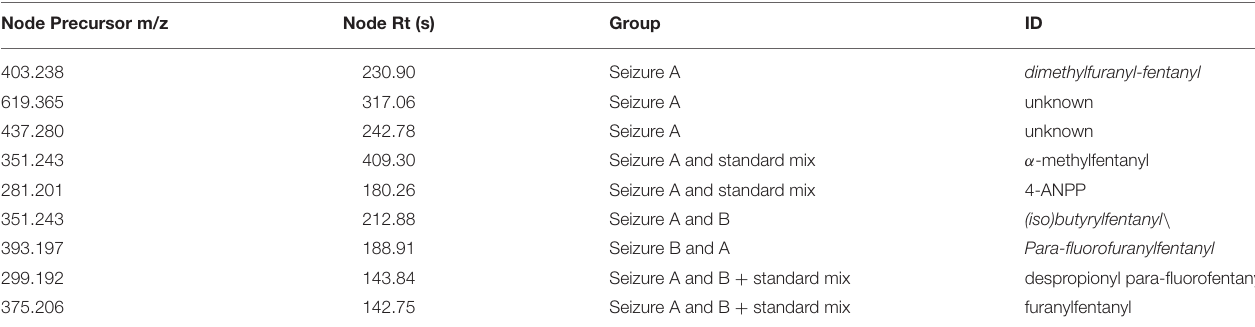
TABLE 3 | Nodes exclusively found in the seizures and nodes common to seizures and standard